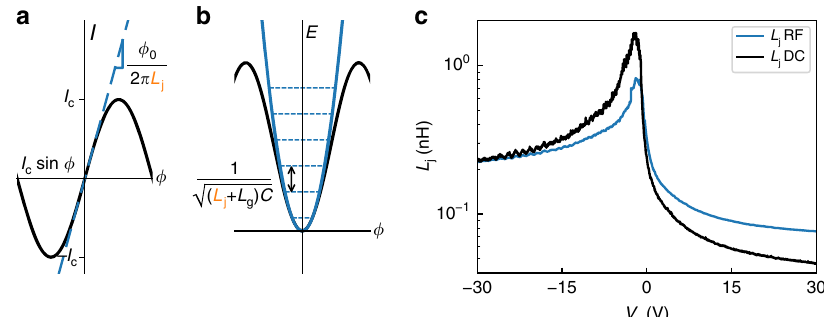
Fig. 3 Josephson inductance extracted from RF and DC measurements. a Schematic representation of L j and its relation to the CPR of a Josephson junction. L j can be understood as the slope of the current-phase relation around zero phase bias. b Schematic representation of resonance frequency. The potential energy near ϕ = 0 is harmonic, with the fundamental frequency given by the junction inductance L j and the cavity ffiffiffiffiffiffiffiffiffiffiffiffiffiffiffiffiffiffiffiffiffiffi L þ L capacitance C and inductance L g as ω ¼ 1 = . c Comparison of Josephson inductance L j extracted from DC measurements (black) and from the j g microwave measurements (blue). We attribute differences to deviations from a sinusoidal current-phase relation (see main text for details). The error band from our fi t of L j can be found in Supplementary Fig.